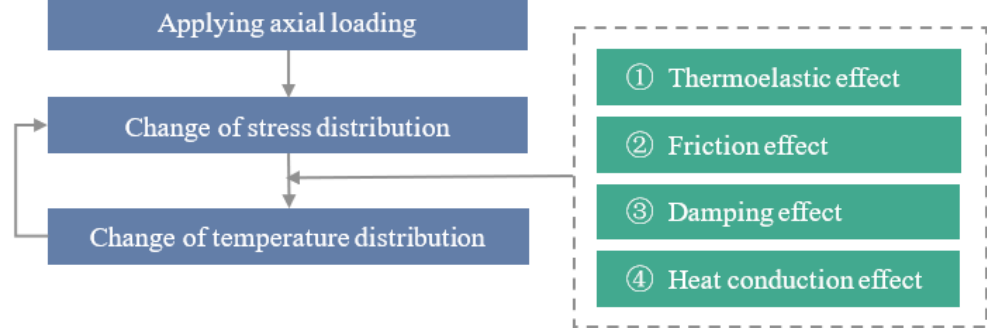
Figure 3. Calculation process of the thermo-mechanical coupling model.